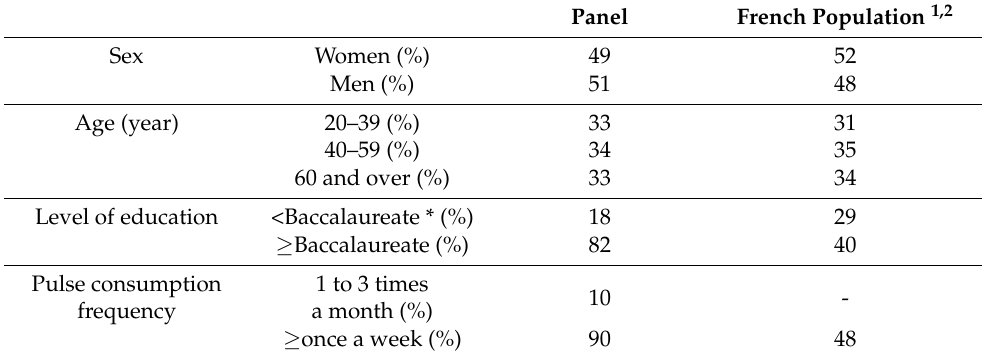
Table 3. Sociodemographic characteristics and pulse consumption frequency of